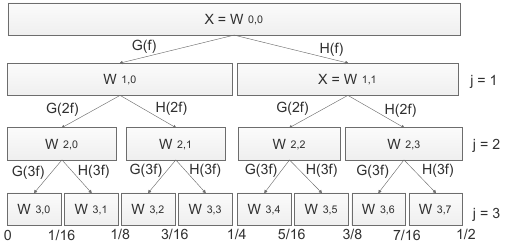
Figure 2. Wavelet packet tree with three